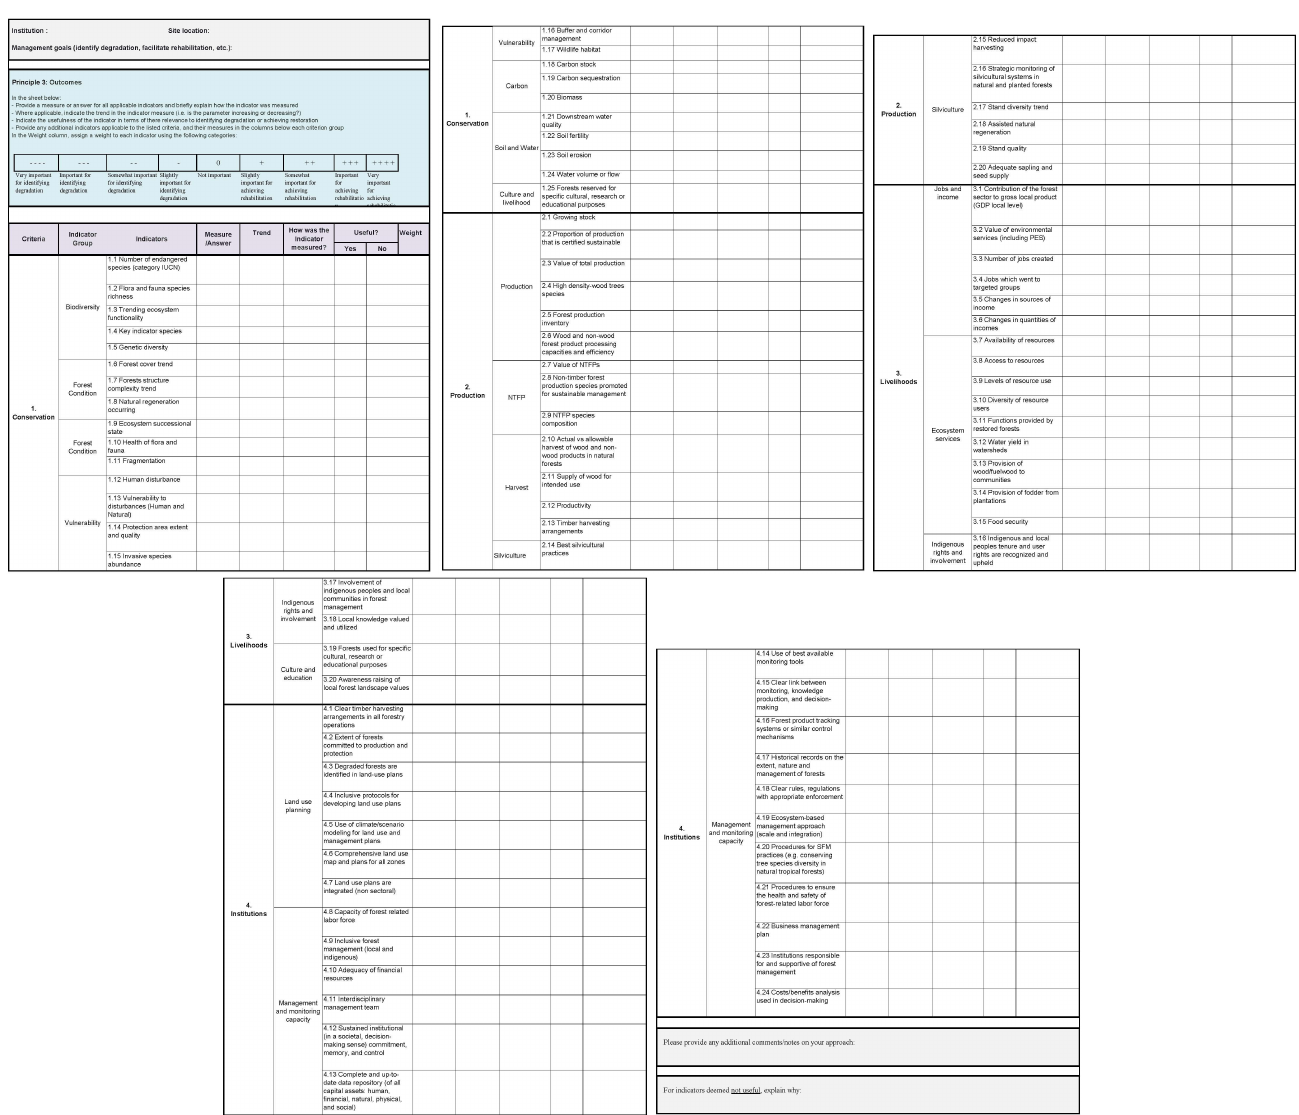
Figure A3. Outcomes Table. References